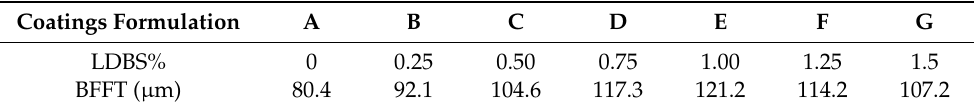
Table 4. E ff ect of LDBS dosage on BFFT.